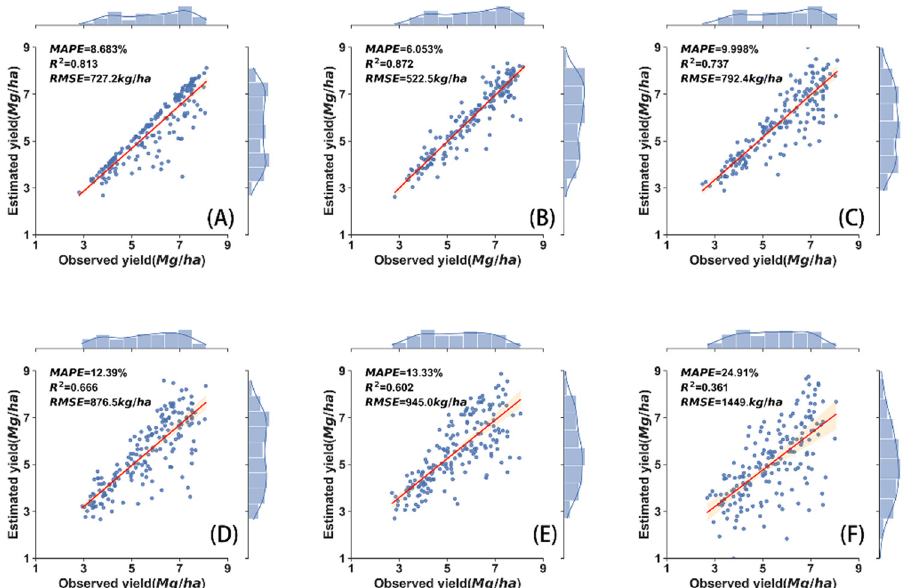
Table 2. The accuracy evaluation of the LSTM prediction model was compared between different time steps when 6 LAI data were input.